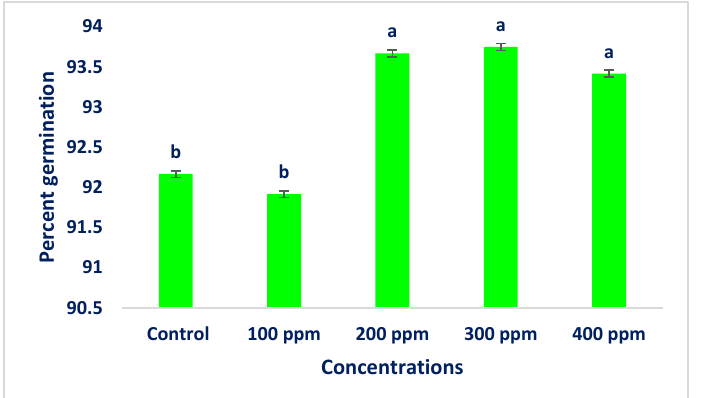
Figure 1. Effect of GA 3 concentration during cultivation on the percent of germination of produced cauliflower seeds. Means followed by same letter(s) within a column do not differ significantly at 5% level of probability by DMRT. The percentage of germination of produced cauliflower seeds was not significantly influenced by the GA 3 application at different times during cultivation. (Figure 2).